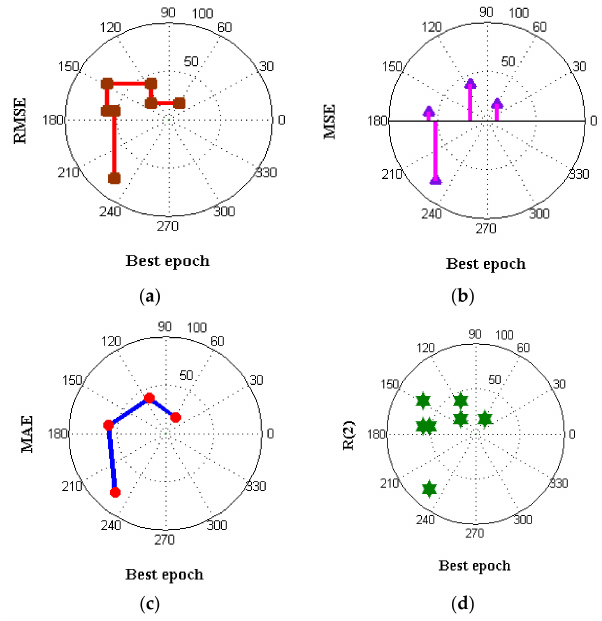
Figure 11. Comparison of errors using PM 2.5 ( a ) RMSE ( b ) MSE ( c ) MAE. The red dots that connect the blue line indicates that with respect to best epoch values the error values are reduced. ( d ) R 2 . The star marks indicate the R 2 values achieved for corresponding